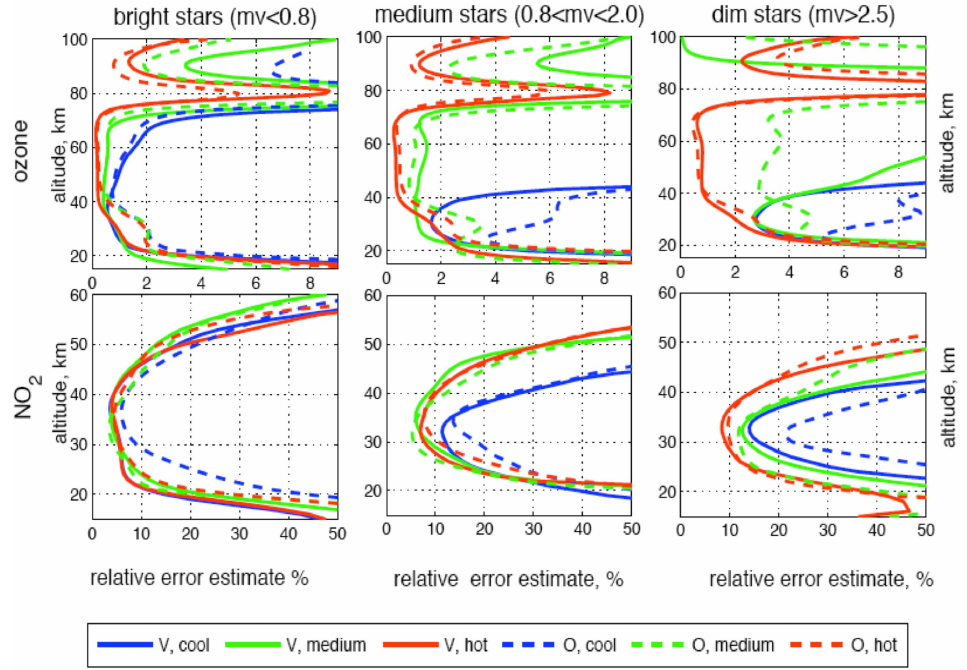
Fig. 22. GOMOS error estimates for O 3 (top row), and NO 2 (second row) for representative cases: bright star (left column), typical star (middle column) and dim star (right column). The dashed lines correspond to oblique occultations and the solid lines to occultations in the orbital plane. Stellar temperature is indicated with the line color: hot stars (red), medium stars (green) and cool stars (blue). These values correspond to the most recent version of data processing (GOPR 7.0), which is the baseline for the reprocessing in 2010 (from Tamminen et al.,